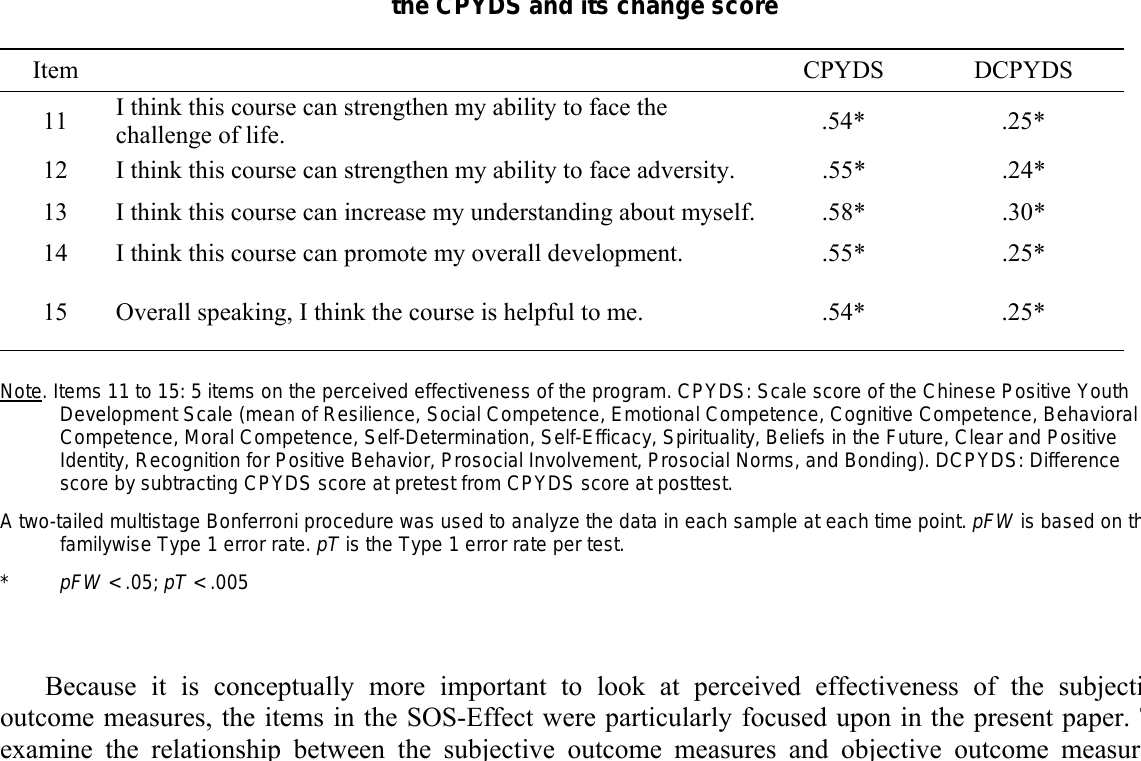
Correlations on the items on perceived effectiveness and objective outcome measures indexed by the CPYDS and its change